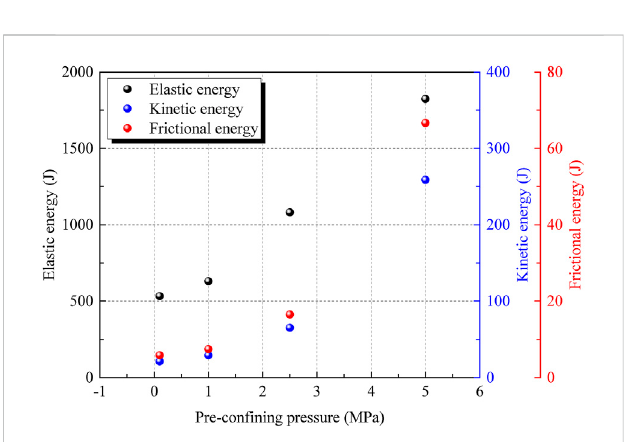
FIGURE 14 Peak elastic energy, peak kinetic energy and peak frictional energy of the coal samples under different pre-con fi ning pressures.